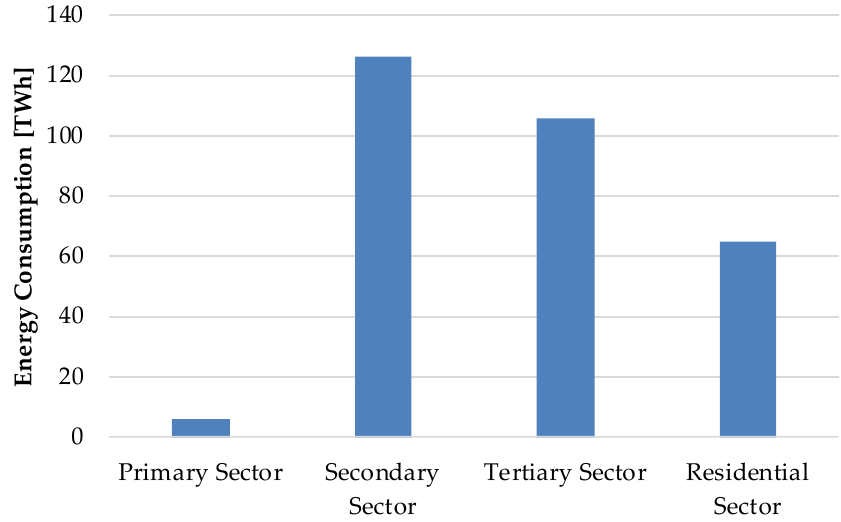
Figure 2. Subdivision among sectors of the energy consumed in Italy.